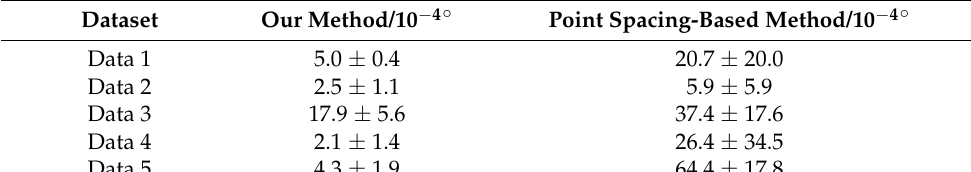
Table 4. Estimation error of vertical angular resolution on each dataset (Mean ± Std).